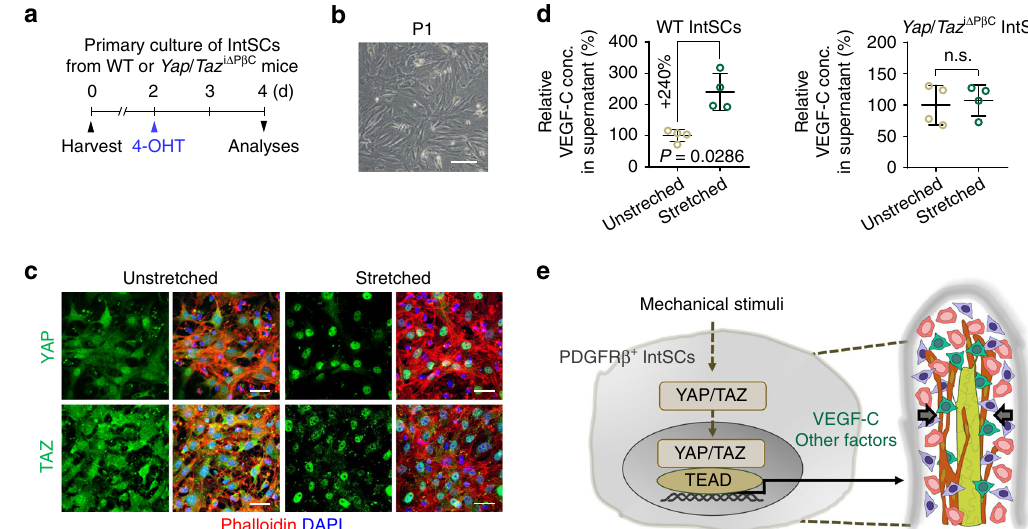
Fig. 6 Mechanical stretching induces YAP/TAZ activation and VEGF-C secretion in IntSCs. a Diagram for primary culture of IntSCs derived from WT or Yap/Taz i Δ P β C mice for 2 days and their analyses at 2 days after 100% EtOH or 5 µ M of hydroxy-tamoxifen (4-OHT) treatment. b Phase-contrast image of freshly isolated primary mouse IntSCs from WT mice without passage (P1). Similar results were observed in four independent experiments. Scale bar, 200 μ m. c Representative images of YAP and TAZ with phalloidin + actin fi laments in unstretched and stretched IntSCs. Similar fi ndings were observed in four independent experiments. Scale bars, 50 μ m. d Comparison of VEGF-C protein concentration in the culture medium of unstretched and stretched IntSCs derived from WT or Yap/Taz i Δ P β C mice. Dots indicate value from four independent experiments and horizontal bars indicate mean ± SD. P value versus unstretched by two-tailed Mann – Whitney U test. e Schematic images depicting upregulation and secretion of VEGF-C and other factors upon nuclear translocation and activation of YAP/TAZ and subsequent binding to TEAD after mechanical stimuli in PDGFR β +